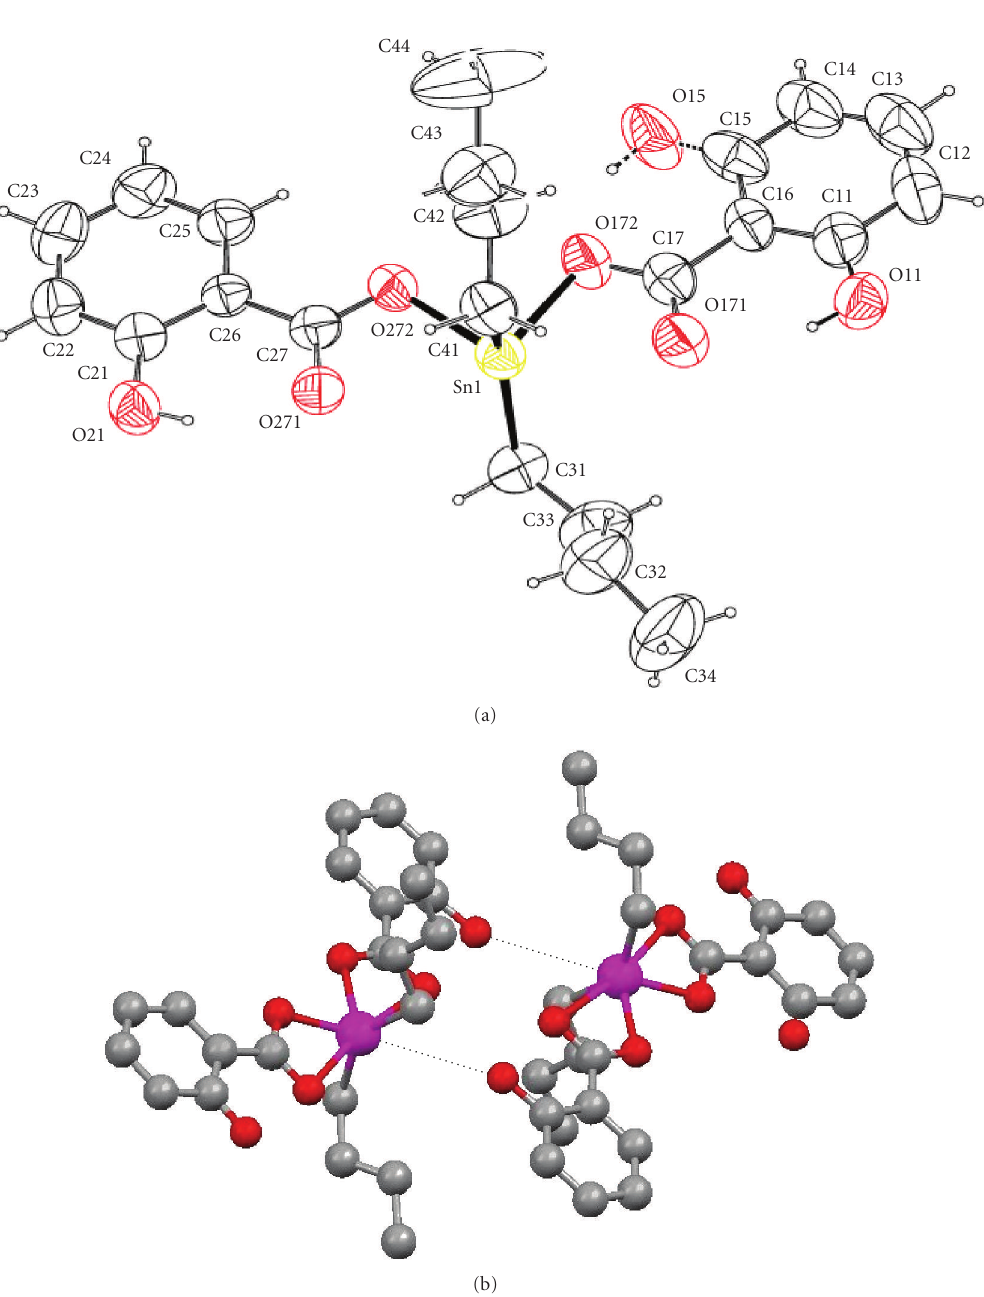
Figure 2: (a) Anisotropic ellipsoid representation of complex 2 . The ellipsoids are drawn at 50% probability level. Selected bond distances ( ˚A) and bond angles (deg.): Sn1-O172 = 2.121(3), Sn1-O171 = 2.565, Sn1-O272 = 2.105(4), Sn1-O271 = 2.632, Sn1-C31 = 2.120(6), Sn1- C41 = 2.111(5), O172-Sn1-O272 = 81.66(13), O171-Sn1-O271 = 170.01, and O272-Sn1-O172-C17 = 177.6(4) ◦ . (b) Strong Sn ··· O bonding interaction leads to the formation of a